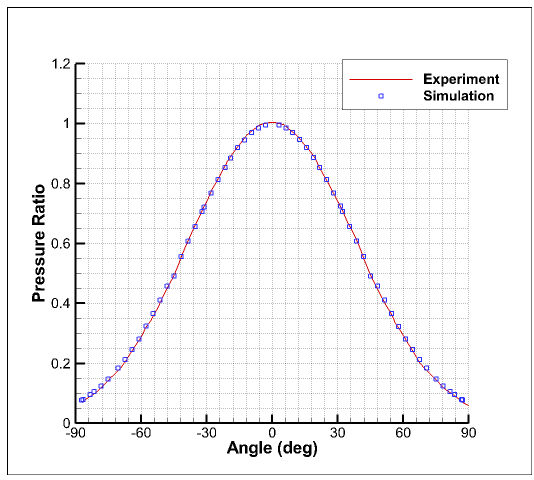
Figure 2. Comparison of pressure on the surface.